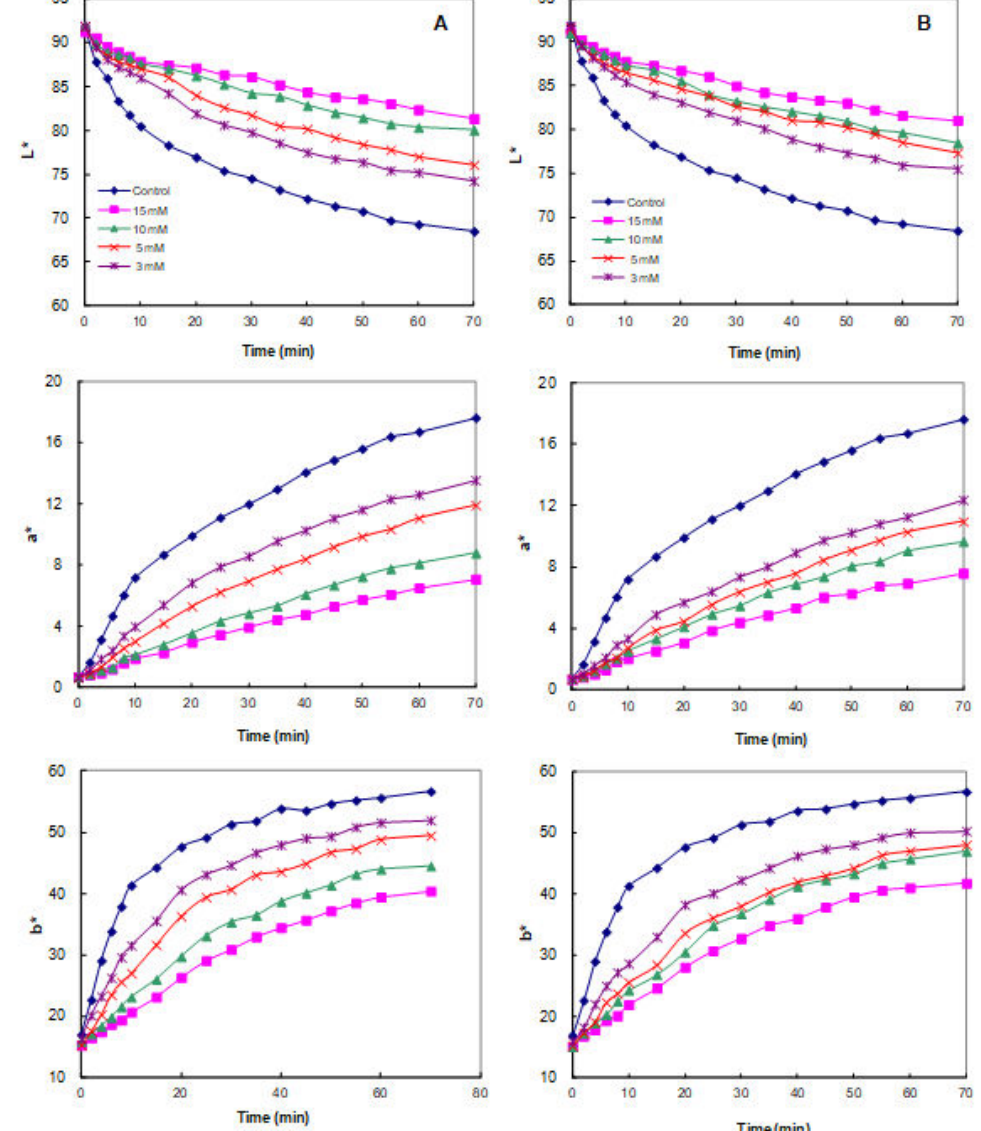
Figure 4. The variation of lightness ( L *), redness ( a *), and yellowness ( b *) value of apple juice in the absence (control) and presence (concentrations of 3, 5, 10, and 15 mM) of ( A ) cyclodextrin (CD) or ( B ) cycloamylose (CA). Each data point is the mean of three